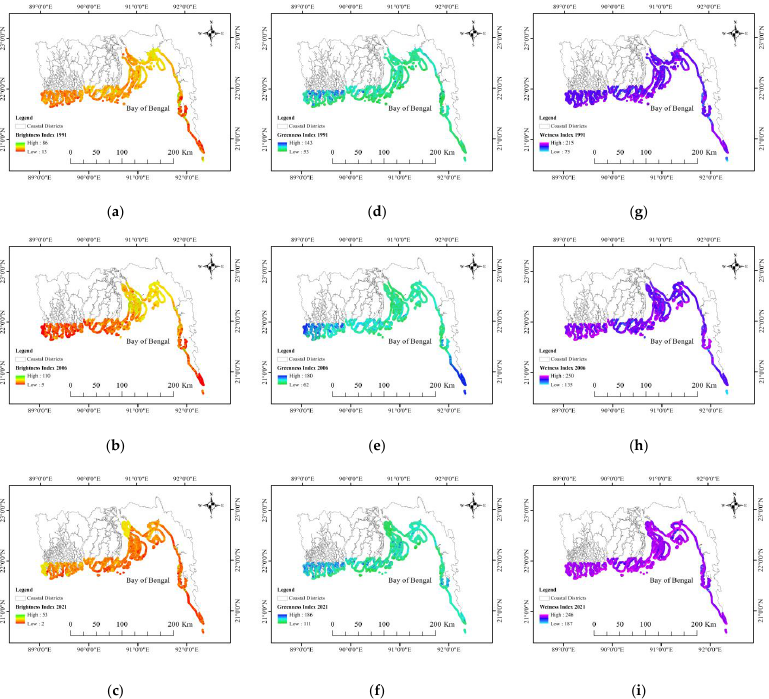
Figure 8. Onshore brightness index: ( a ) 𝑆𝐵 1 of 1991, ( b ) 𝑆𝐵 2 of 2006, and ( c ) 𝑆𝐵 3 of 2021; Onshore greenness index: ( d ) 𝑆𝐺 1 of 1991, ( e ) 𝑆𝐺 2 of 2006, and ( f ) 𝑆𝐺 3 of 2021 ; Onshore wetness index: ( g ) 𝑆𝑊 1 of 1991, ( h ) 𝑆𝑊 2 of 2006, and ( i ) 𝑆𝑊 3 of 2021 of coastal districts, Bangladesh delta.